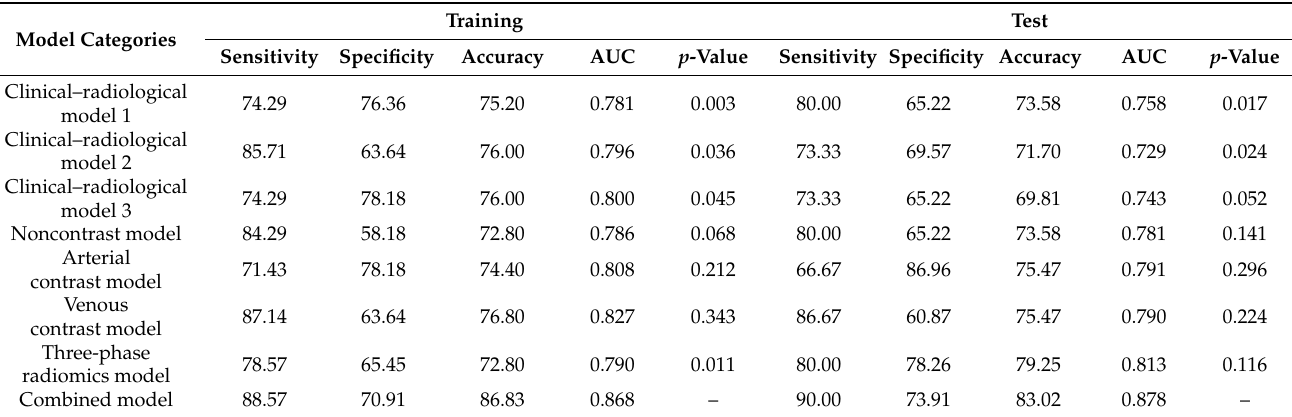
Table 4. Diagnostic performance of the models.